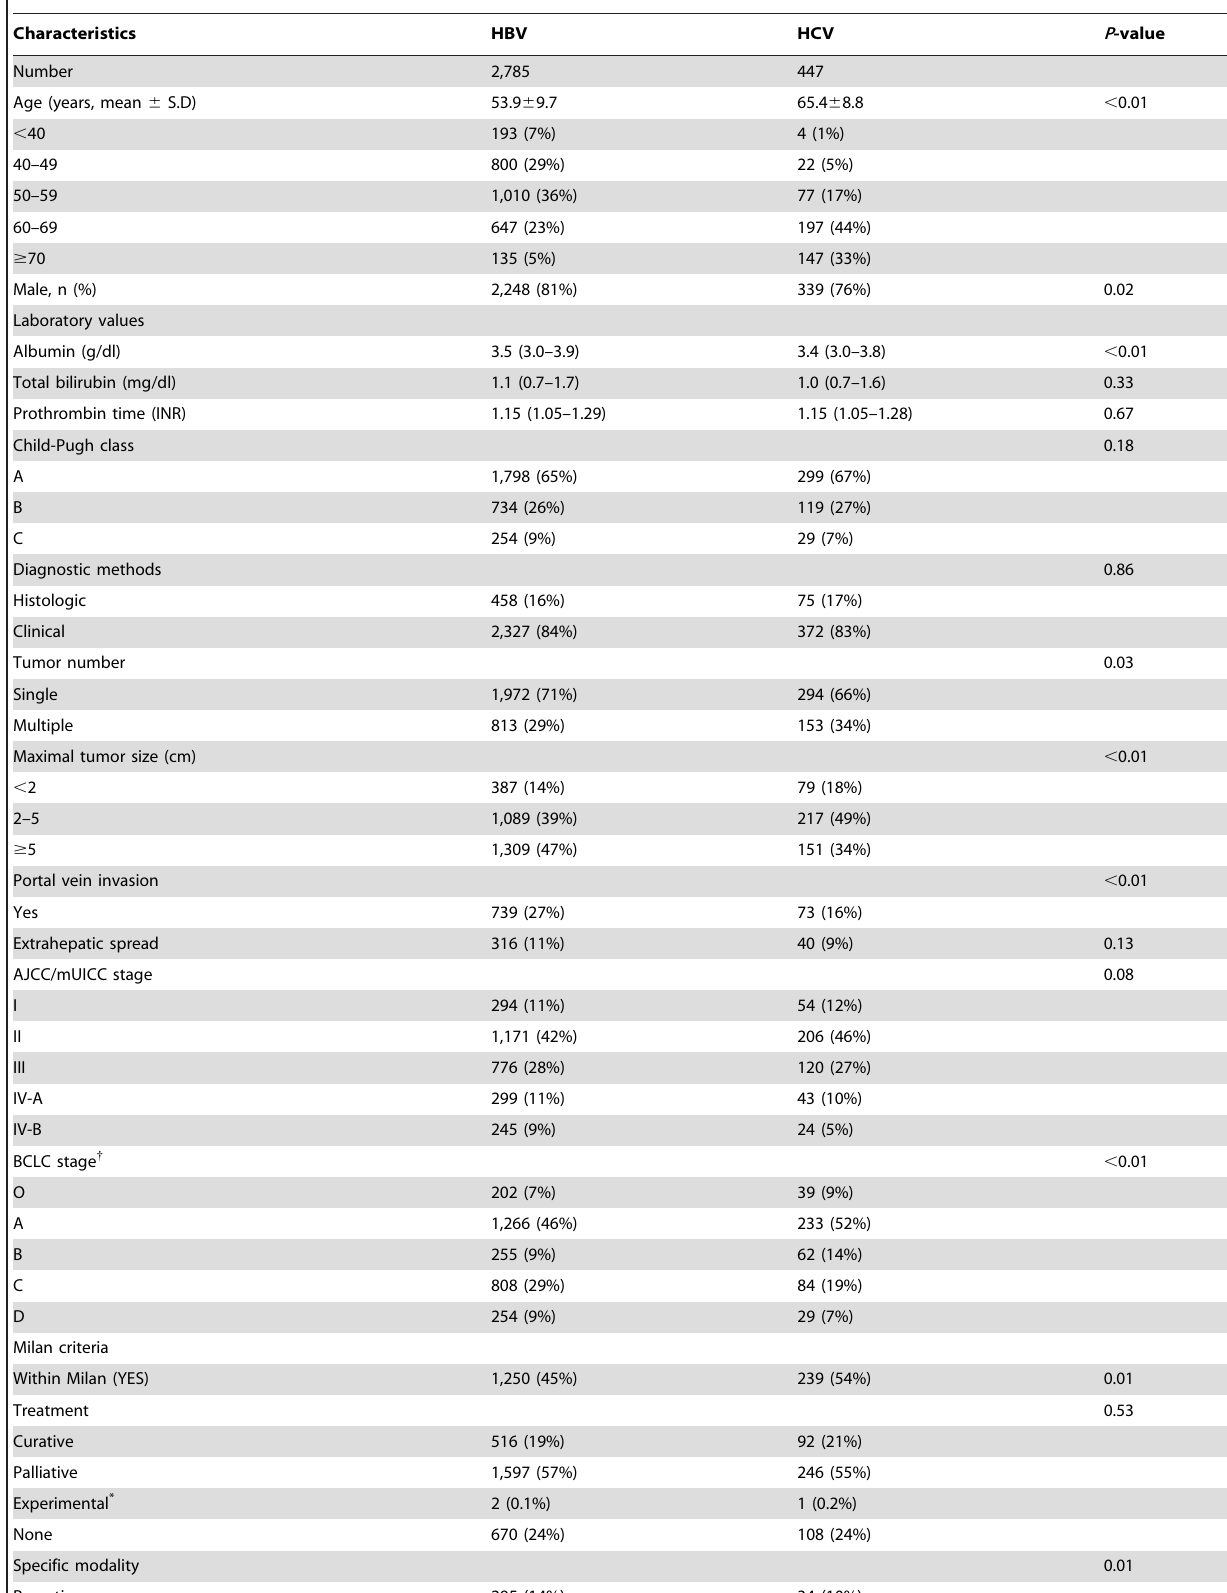
Table 1. Characteristics of study